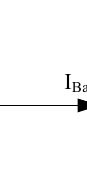
Figure 8. The proposed control strategy for HESS.